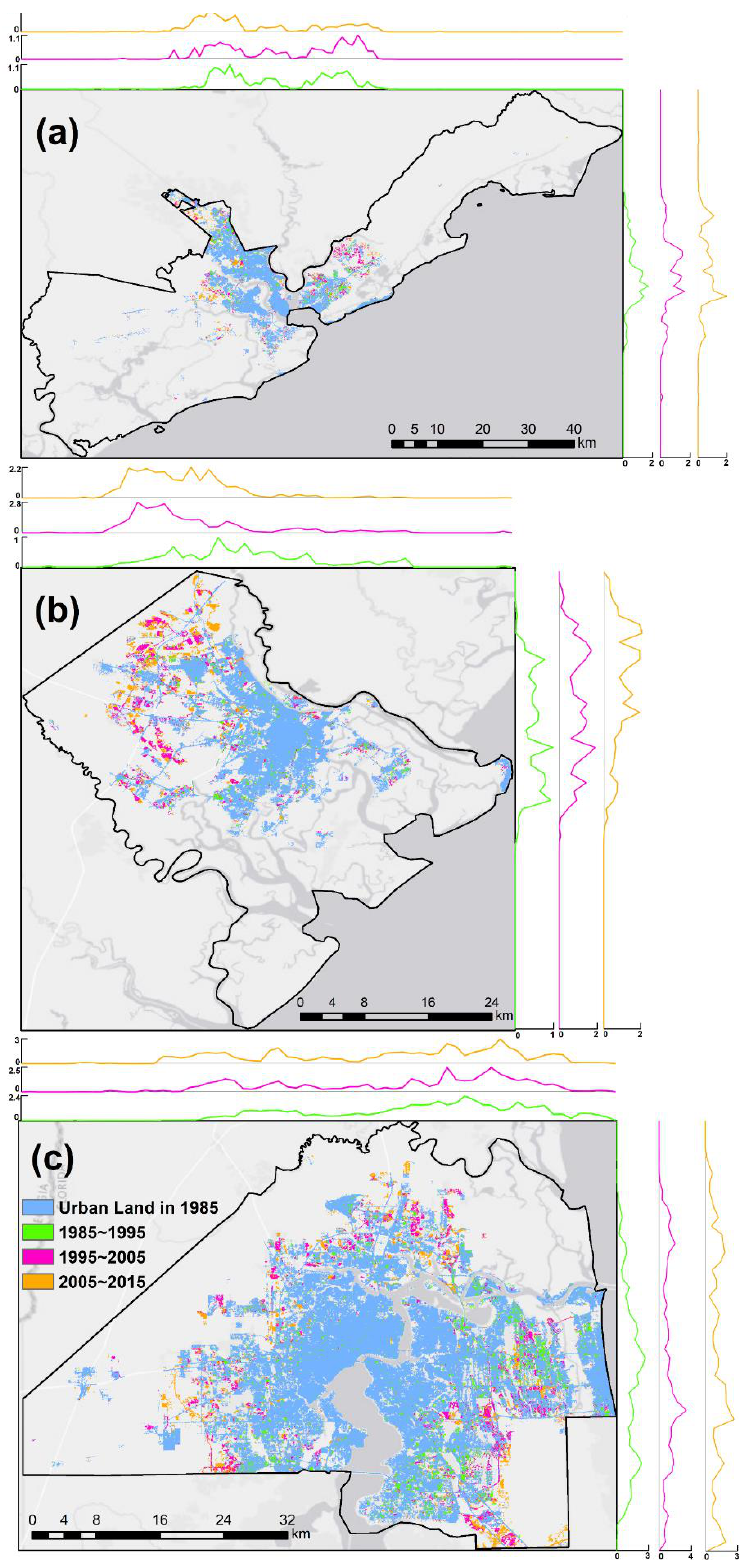
Figure 8. The spatial distribution of urban expansion in ( a ) Charleston, SC, ( b ) Chatham, GA, and ( c ) Duval, FL, between 1985 and 1995 (green); 1995 and 2005 (pink); and 2005 and 2015 (orange). The area changes (in km 2 ) summarized by latitudes and longitudes are visualized as line charts along map edges. (The World Light Gray Basemap is used as the background, which is provided by Esri, HERE, Garmin, © OpenStreetMap contributors, and the GIS User Community.)